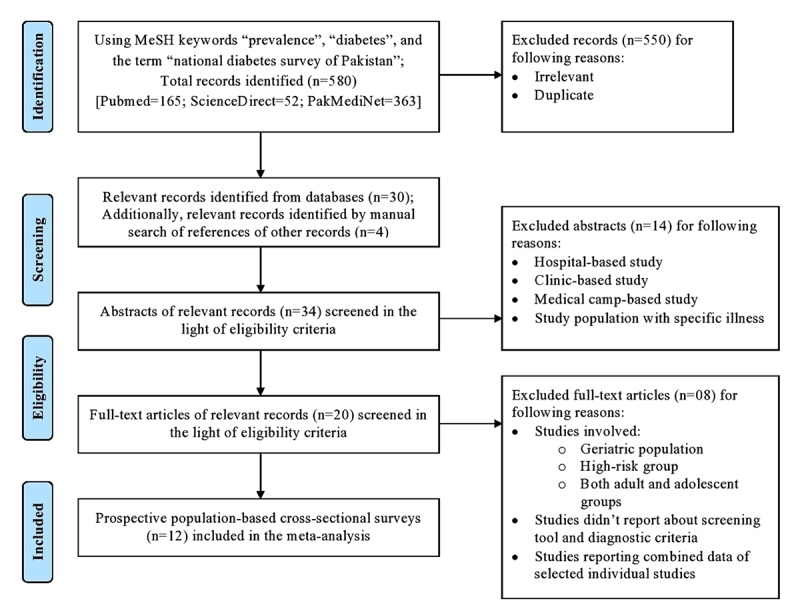
PRISMA flow diagram showing selection process of included studies.